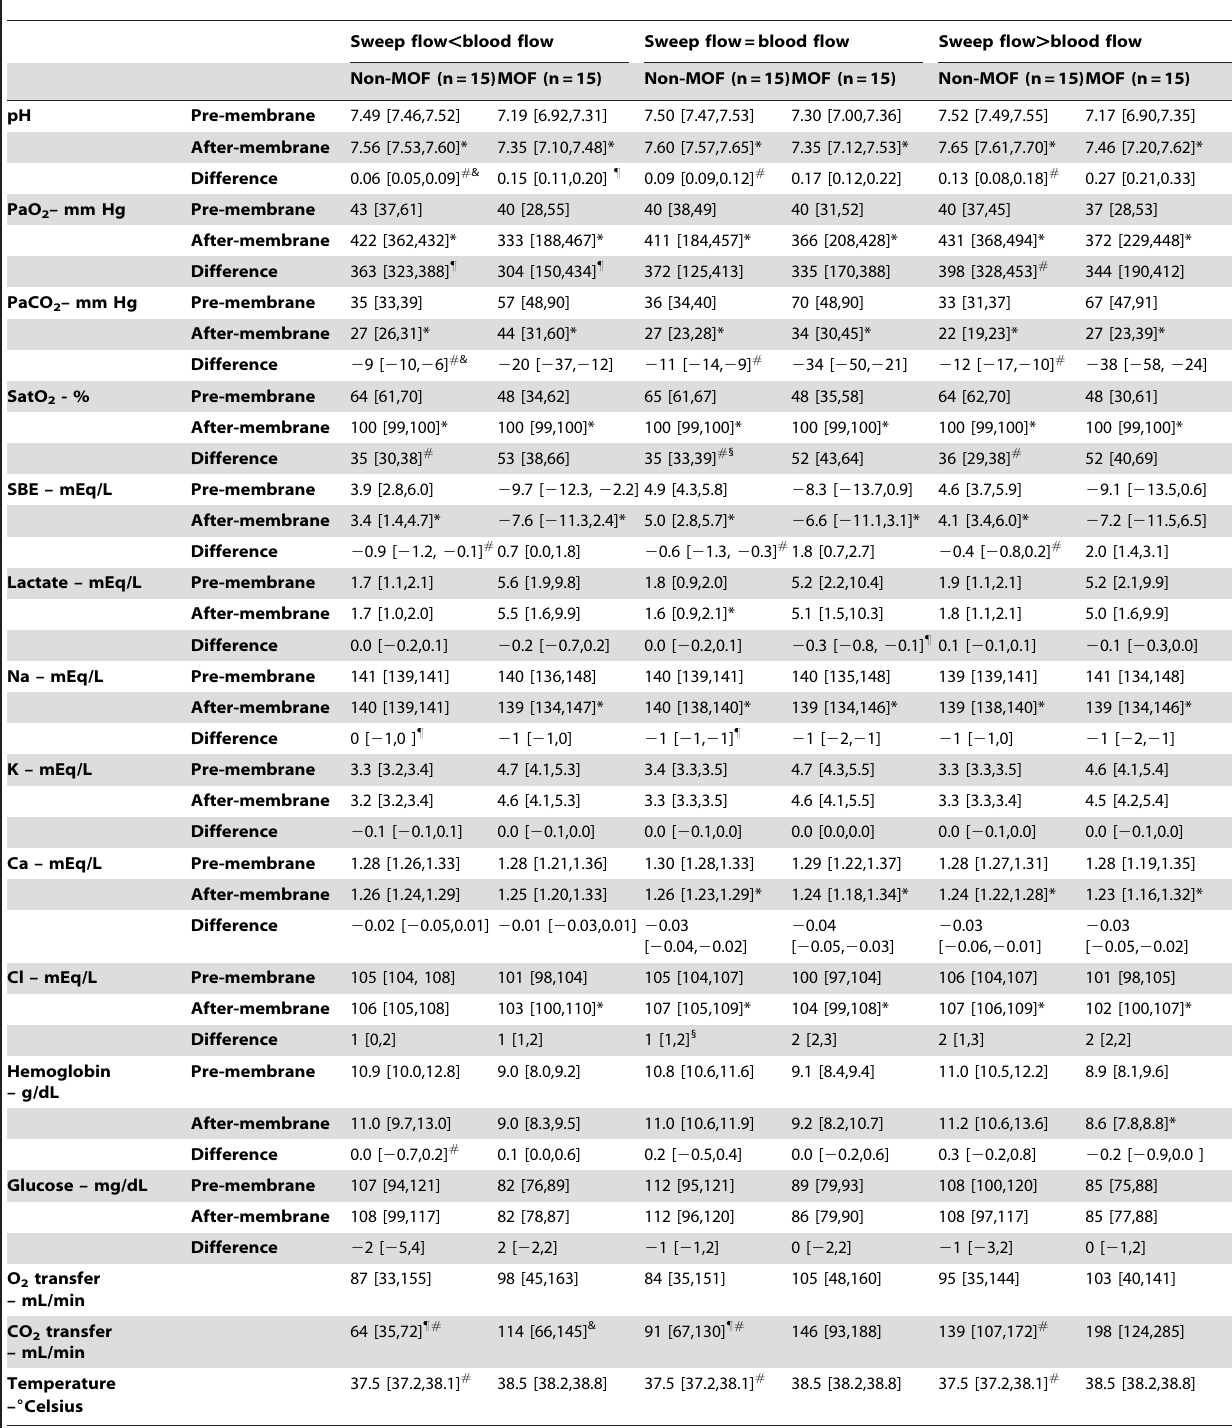
Table 5. Comparison of laboratory variables between the blood samples acquired pre and after the oxygenation membrane, during different ratios between sweep and blood flows, with and without